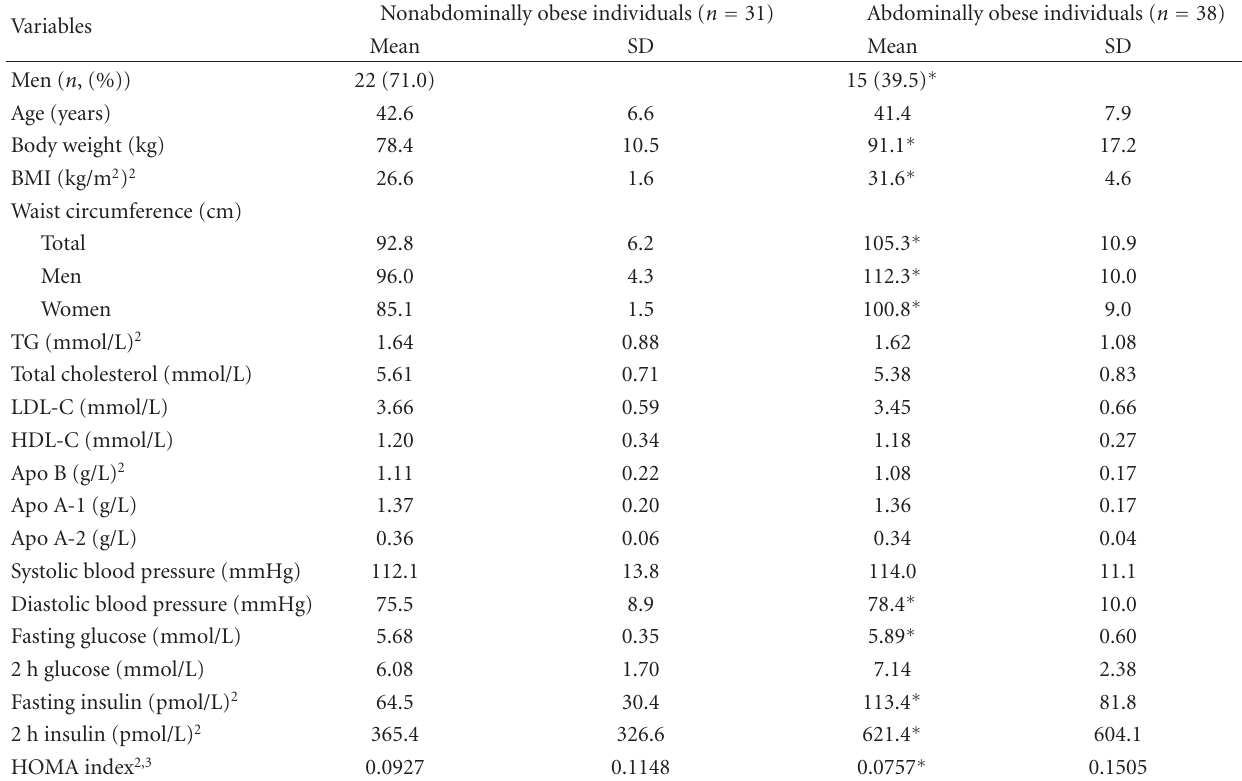
Table 3: Characteristics of subjects before the 4-week controlled Mediterranean diet intervention 1 .